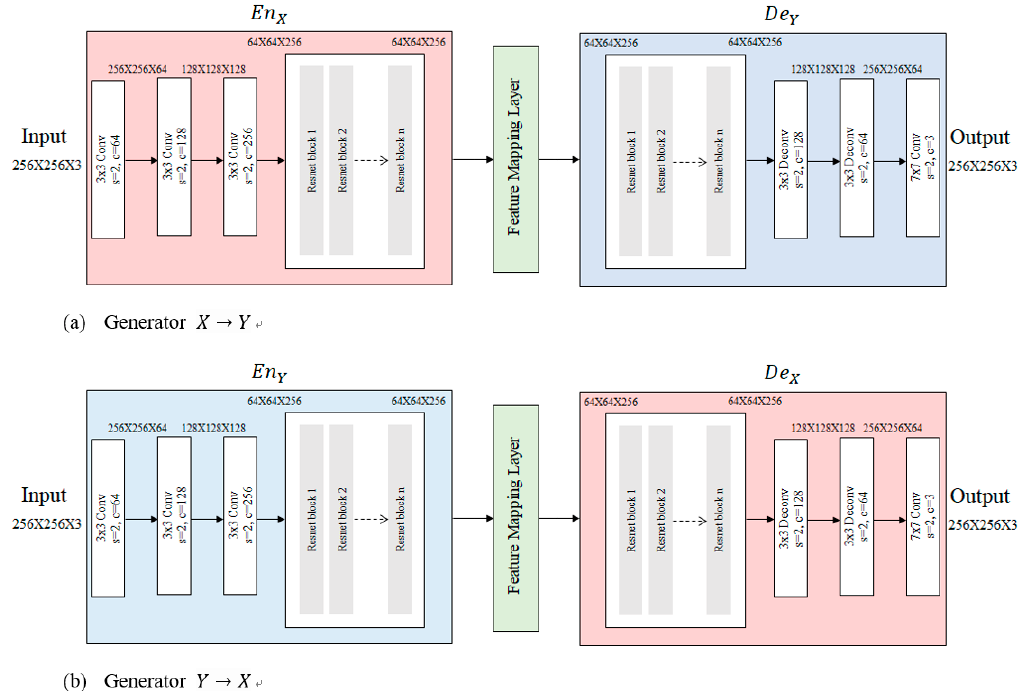
Figure 5. CycleGAN-based generator architecture of our model. Cross-connected structure of the pre-trained encoder and decoder with feature mapping layer and residual connection of residual block. ( a ) Generator in our model for translating images from domain X to Y. ( b ) Generator in our model for translating images from domain Y to X.